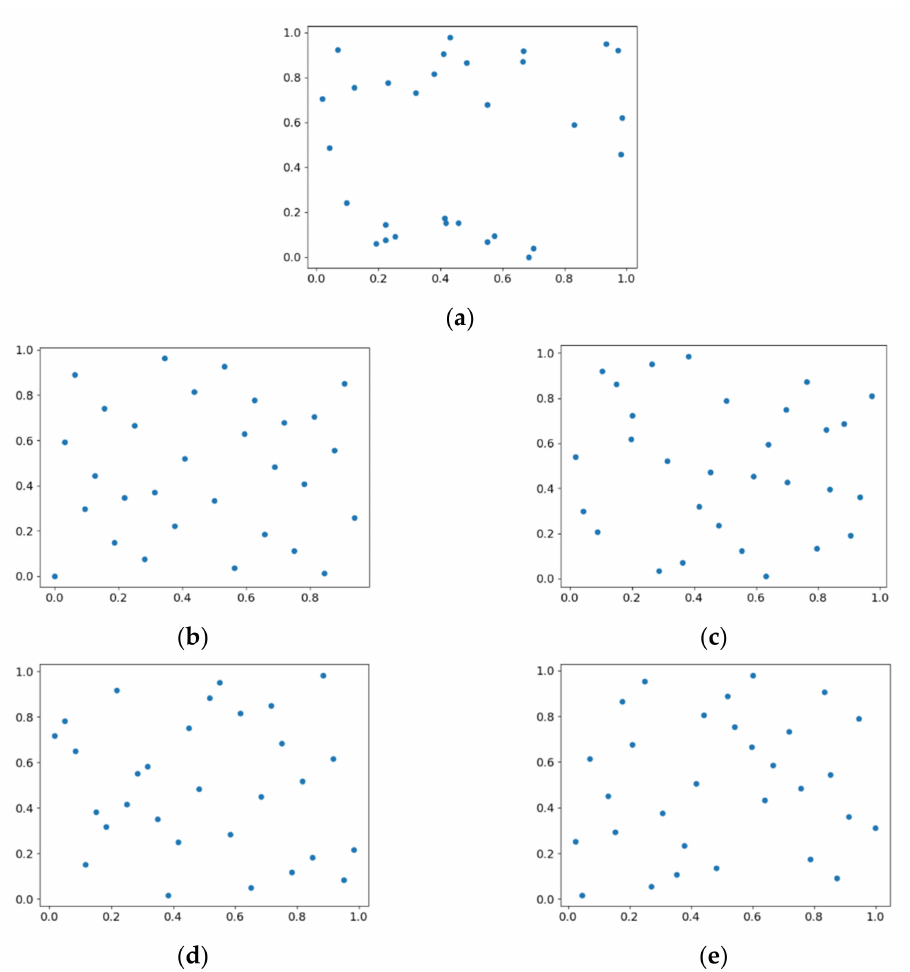
Figure 3. Tested sampling methods exemplified by generating 30 points in a 2D point space: ( a ) uniform sampling; ( b ) Halton sampling; ( c ) Classic Latin Hypercube sampling (LHS); ( d ) Centered Latin Hypercube (CLHS); ( e ) Maximin Latin Hypercube (MLHS). The images illustrate that